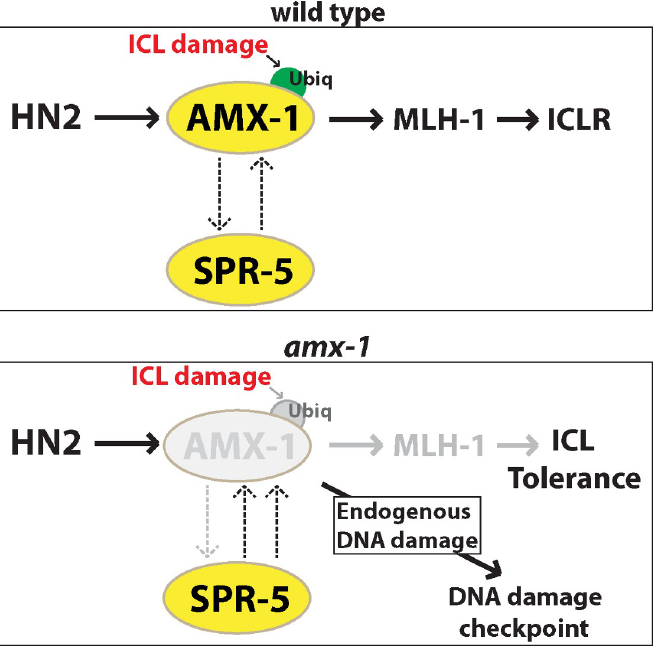
Fig 8. Model for the role of histone demethylase AMX-1 in DNA damage repair. Top, in wild-type animals, we propose that AMX-1 and SPR-5 act in both redundant and non-redundant manners. Upon ICL damage, AMX-1 is ubiquitylated and regulates the proper expression of MLH-1 (mismatch repair MutL homolog). Bottom, in the absence of AMX-1, SPR-5 expression is up-regulated. A DNA damage checkpoint is activated in amx-1 mutants in the absence of exogenous damage, suggesting that lack of AMX-1 responds to endogenous DNA damage. Upon HN2 exposure, lack of AMX-1 leads to reduced MLH-1 expression and ICL tolerance.